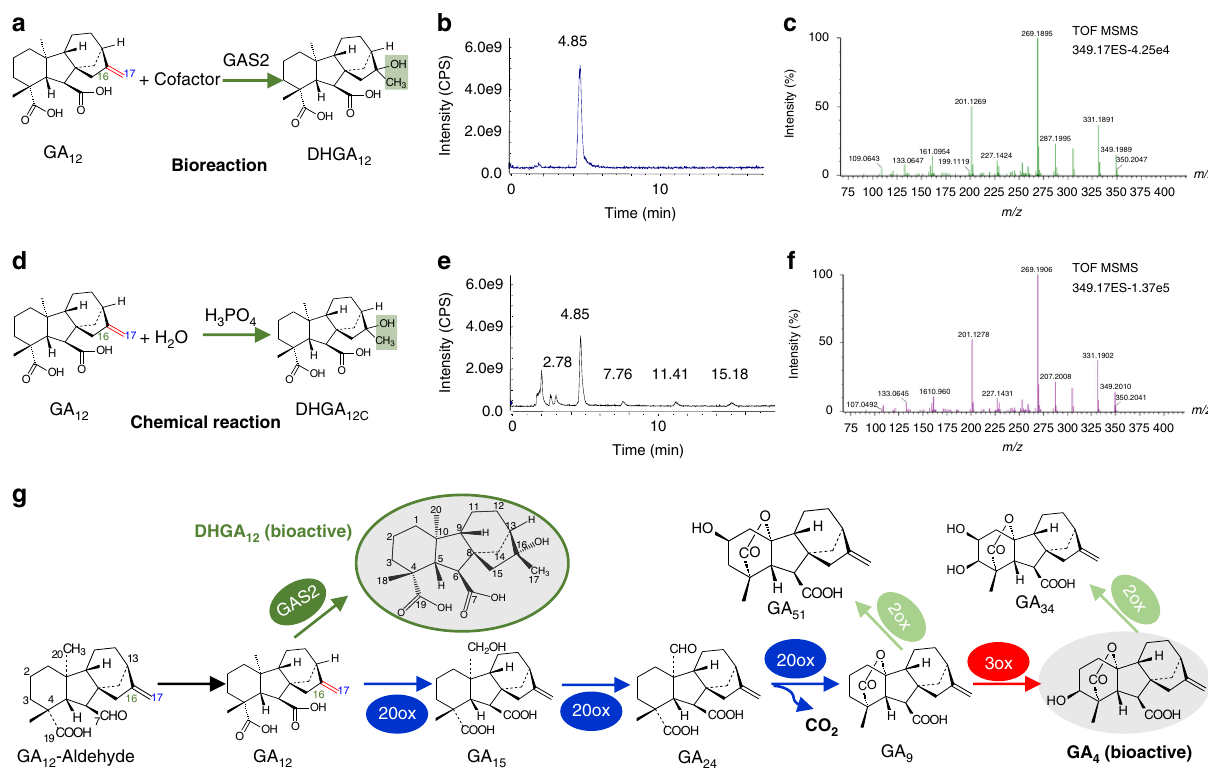
Fig. 4 LC-MS analysis of the new gibberellin, DHGA 12 and its position within the GA biosynthetic pathway. a Schematic of the GAS2-catalyzed conversion of GA 12 to DHGA 12 . Cofactor: 24 µ L, containing 133 mM 2-oxoglutarate, 133 mM ascorbate, 16.7 mM FeSO 4 , and 33.3 mg/mL catalase. b Total ion chromatogram (TIC) of DHGA 12 by LC-MS. c MS spectrum of the peak at 4.85 min (retention time) in ( b ). d Schematic of the chemical synthesis of DHGA 12C (subscript C denotes chemically synthesized DHGA 12 ). The chemical synthesis was conducted in the phosphoric acid solution (0.125 mol/L) at 60 o C for 8 h. e TIC of DHGA 12C by LC-MS. f MS spectrum of the peak at 4.85 min (retention time) in ( e ). g The stereochemical con fi guration of DHGA 12 (green oval) and gibberellin biosynthetic pathway including the GAS2-catalyzed production of DHGA 12 . 20ox GA 20-oxidase, 3ox GA 3-oxidase, 2ox GA 2- oxidase, LC-MS liquid chromatography/mass spectrometry, GA gibberellins, MS Murashige and Skoog